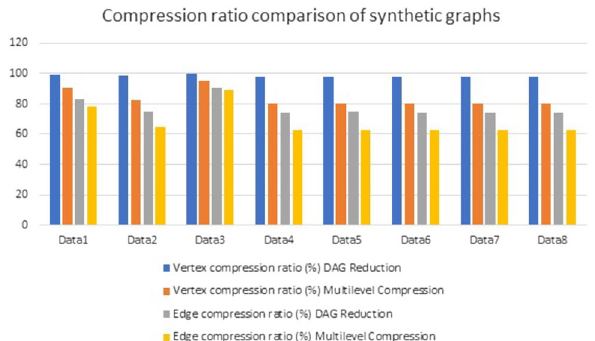
Fig. 6 Vertex and edge compression for G 𝜖 and G c